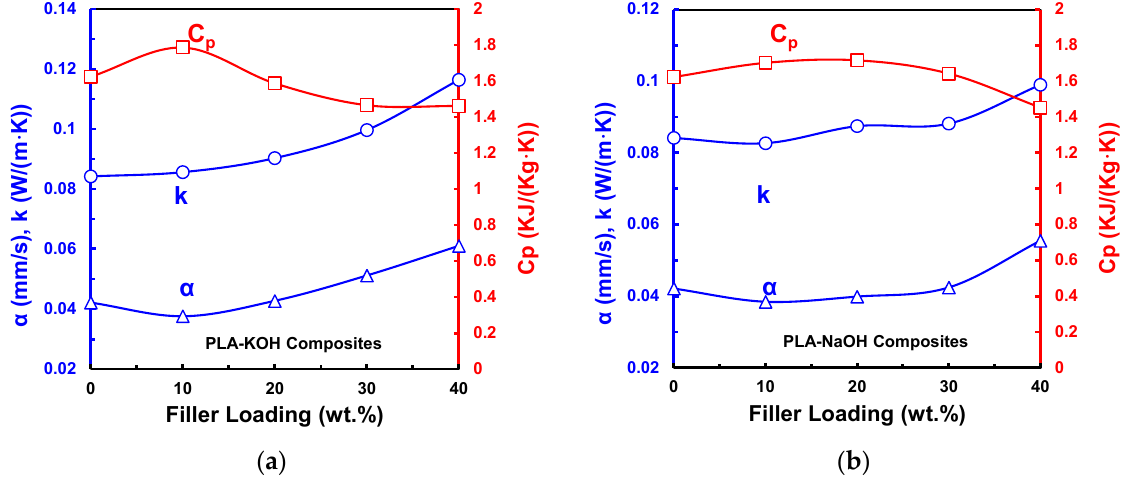
Figure 7. k , C p , and α for ( a ) PLA-KOH; ( b ) PLA-NaOH.